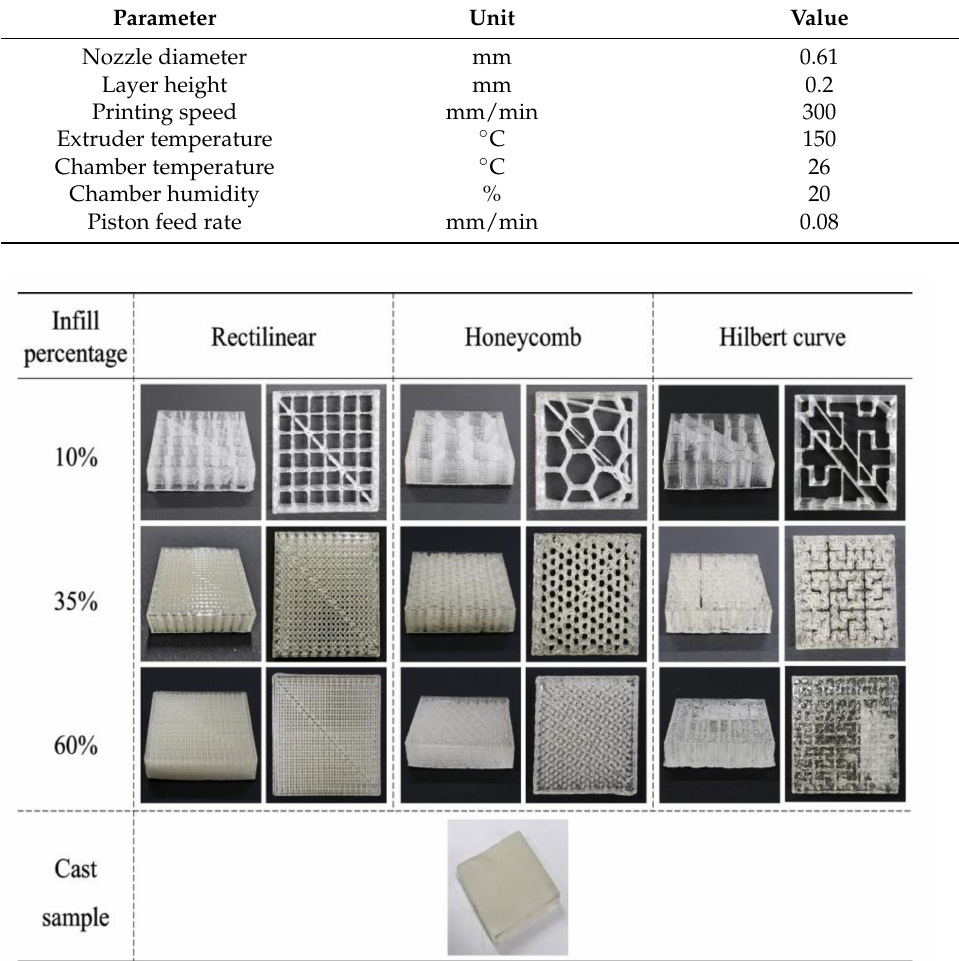
Figure 9. 3D-printed candy